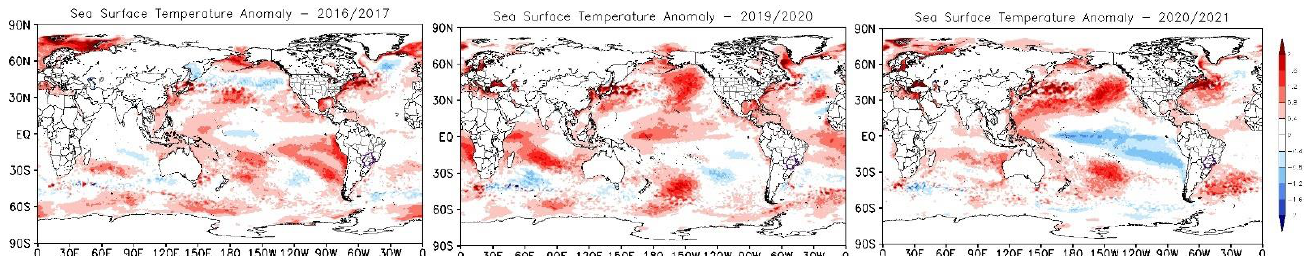
Figure 7. ( a ) OLR and divergent wind anomaly (250 hPa); stream function anomaly for levels ( b ) 250 hPa and (c) 850 hPa. The fields were plotted considering the subtraction of the Oct – Mar average, within the hydrological drought event, from the Oct – Mar climatology (1979 – 2021). The PHR is high- lighted by a purple line and the wave train is indicated by the black dashed lines.